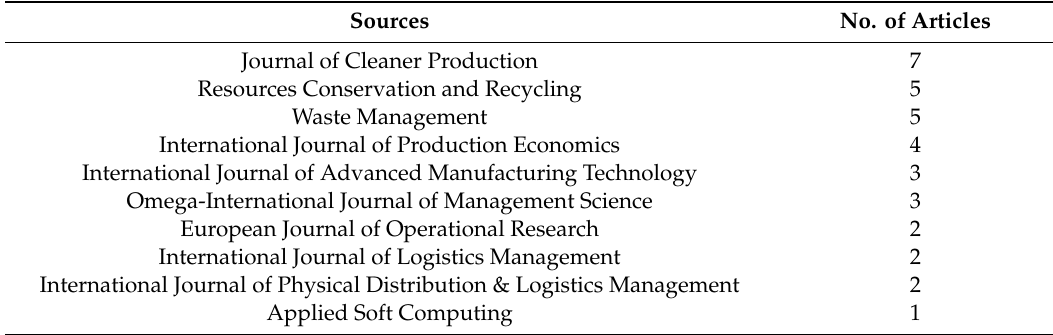
Table 3. Descriptive analysis: Top 10 most frequent journals.